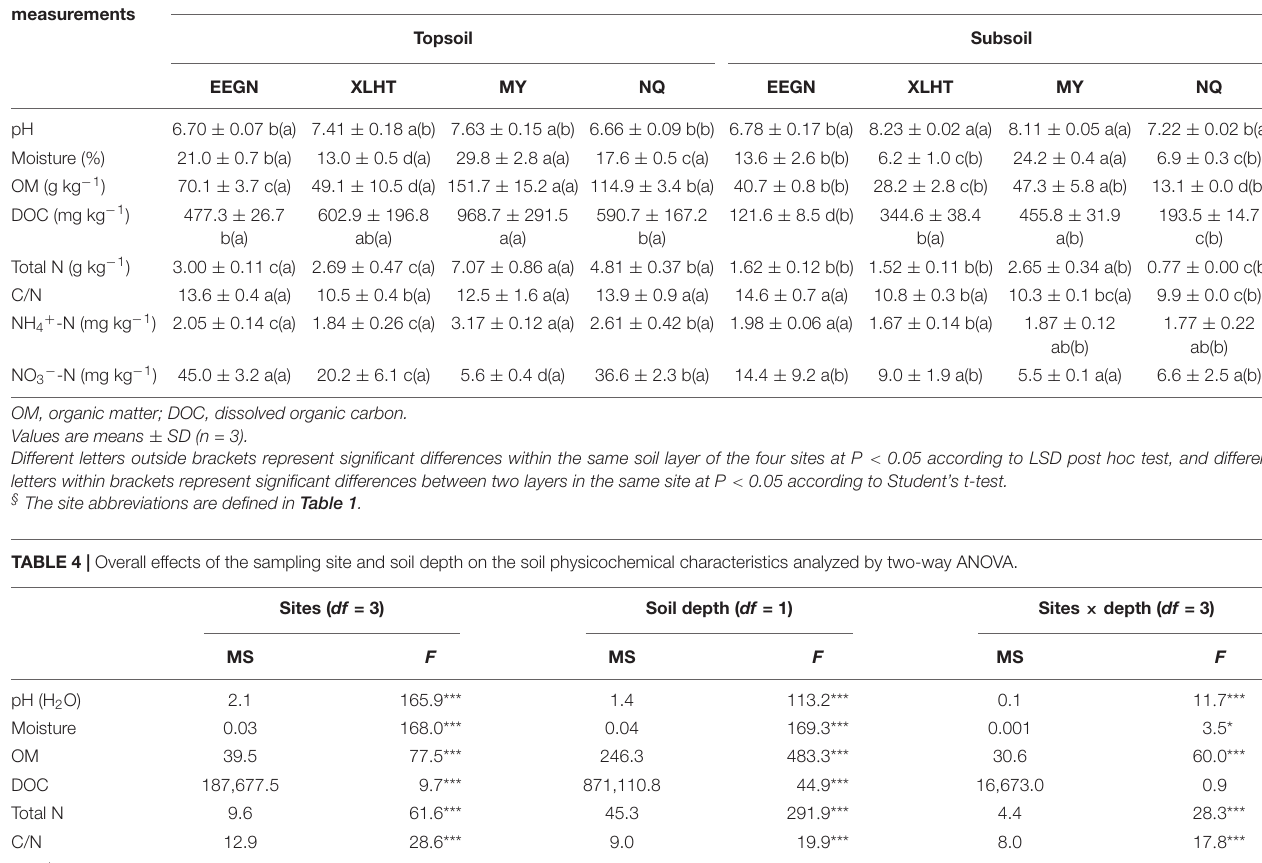
TABLE 3 | Physicochemical characteristics of soils from different natural grassland sites and soil depths. Physicochemical measurements